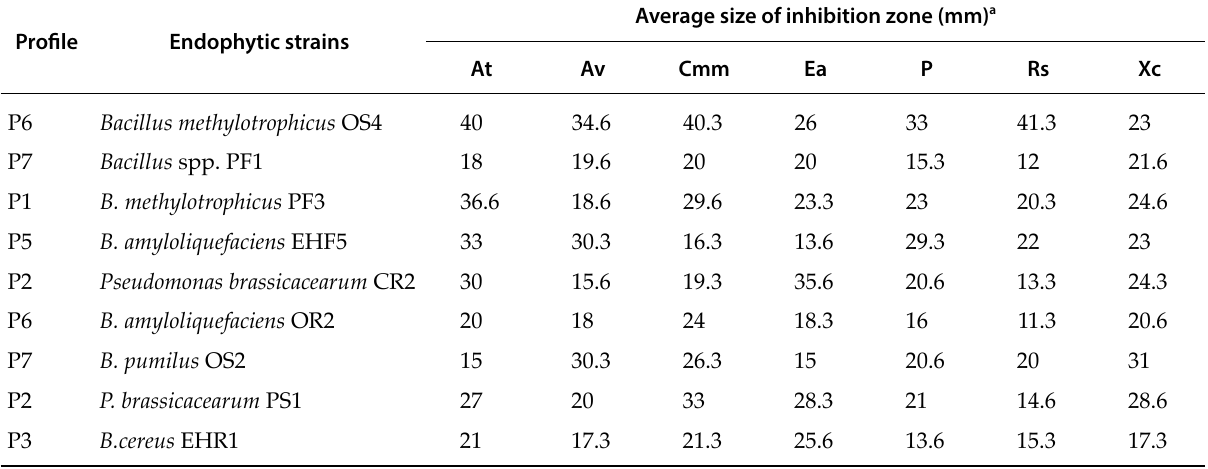
Table 2. In vitro antagonistic activity of representative endophytic bacterial strains of different species against seven plant pathogenic bacteria.